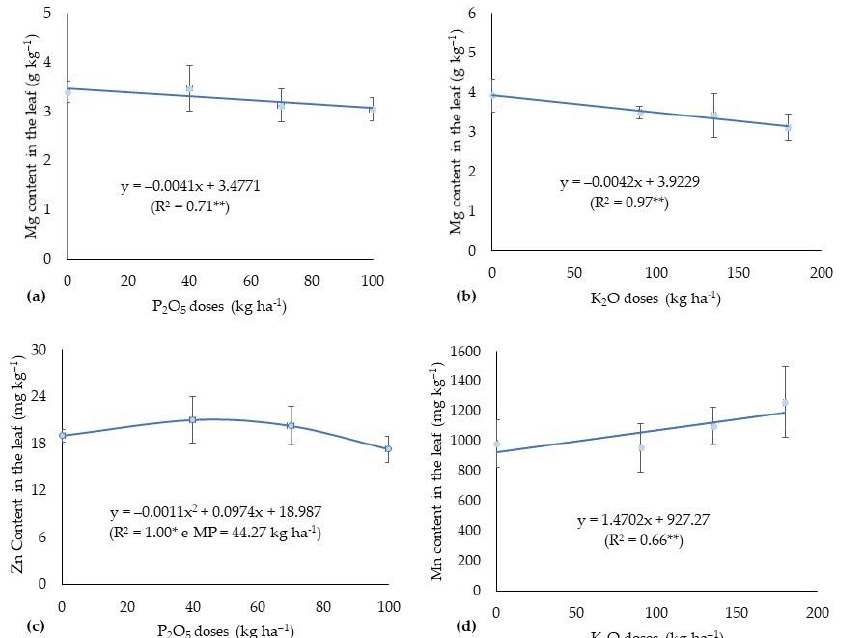
Figure 5. ( a ) Magnesium content in eucalyptus diagnosis leaves as a function of residual P 2 O 5 dose.